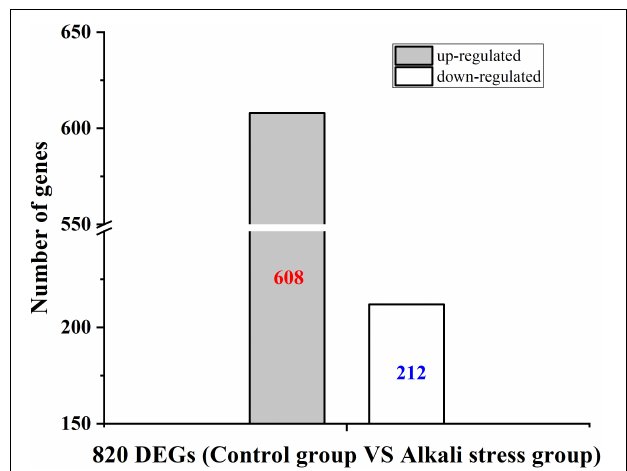
FIGURE 3 | Differential gene expression of control strain and strain after adaptation treatment in the fermentation process under alkali stress.